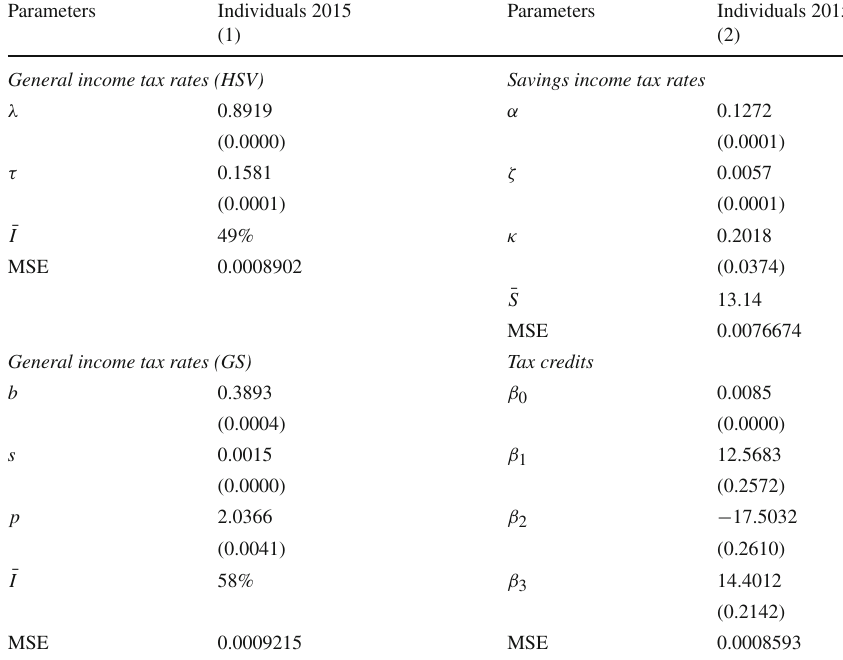
Table 11 Parametric estimates of the tax functions: three-function approach (individuals 2015)